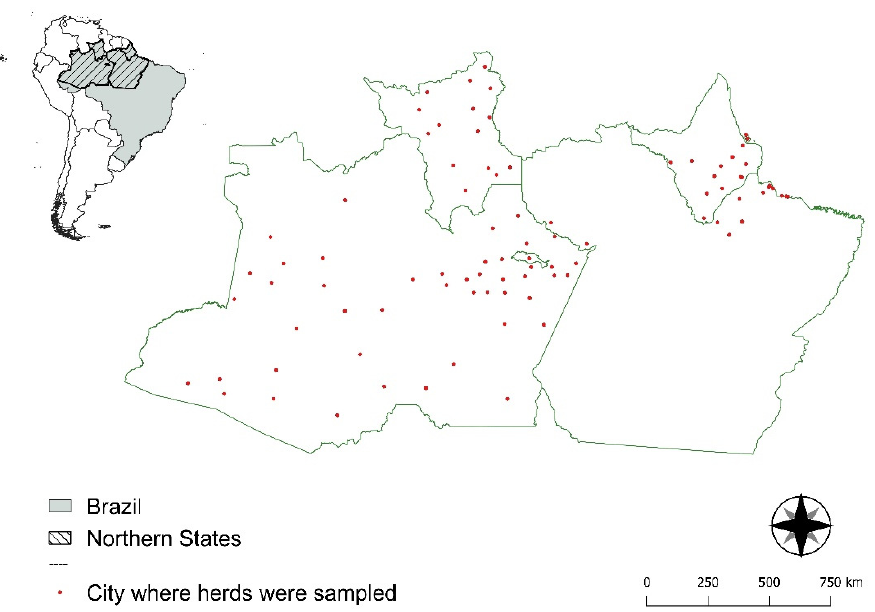
Figure 1. Spatial distribution of the cattle sampled to investigate the presence of ruminant pestiviruses in the states of Pará (PA), Amapá (AP), Roraima (RR), and Amazonas (AM), northern Brazil.